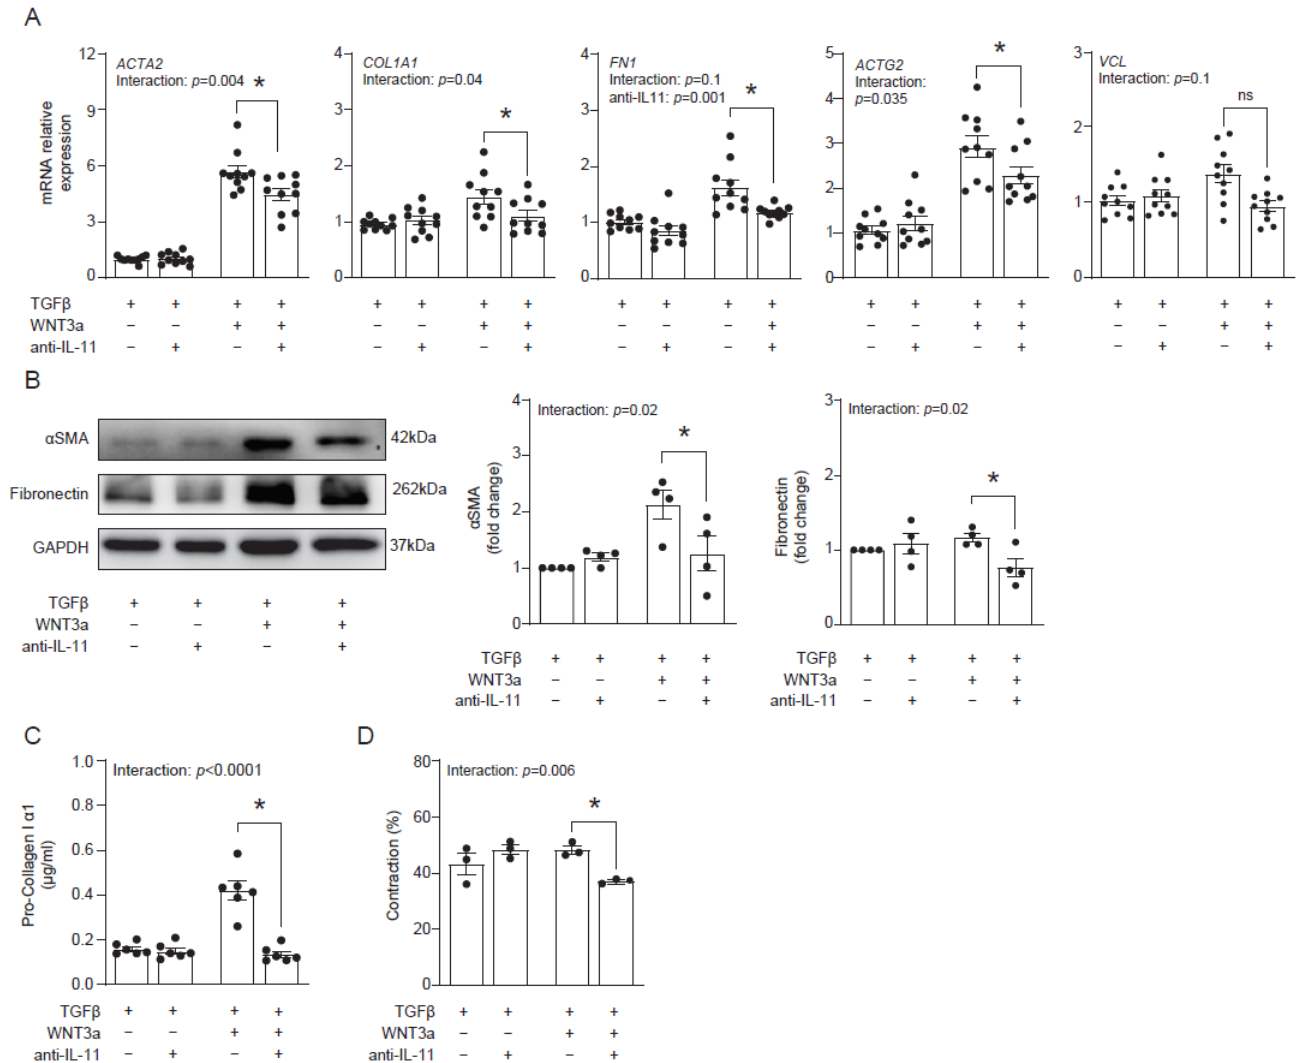
Figure 6. IL-11 contributes to profibrotic response enhanced by WNT3a. Human cardiac fibroblasts were cultured with TGF- β and stimulated with WNT3a in the presence or absence of an anti-IL-11 neutralizing antibody for 72 h. Panel ( A ) presents mRNA levels of profibrotic genes after indicated treatment ( n = 10). Panel ( B ) shows quantification of αSMA and fibronectin ( n = 4) and the representative immunoblots. Pro- collagen I α1 levels measured in supernatants ( n = 6) are presented in panel ( C ). Panel ( D ) shows quantification of gel contraction ( n = 3) containing cardiac fibroblasts pre-treated as indicated. Bars and whiskers represent means ±SEM. The main effect of WNT3a-TGF- β, the anti-IL11 antibody and their interaction were tested using two- way ANOVA followed by Tukey’s multiple comparisons test, when the p -value for interaction wa s ≤ 0.1; * p < 0.05 (post-hoc TGF- β+WNT3a vs. TGF - β+WNT3a+anti - IL11).